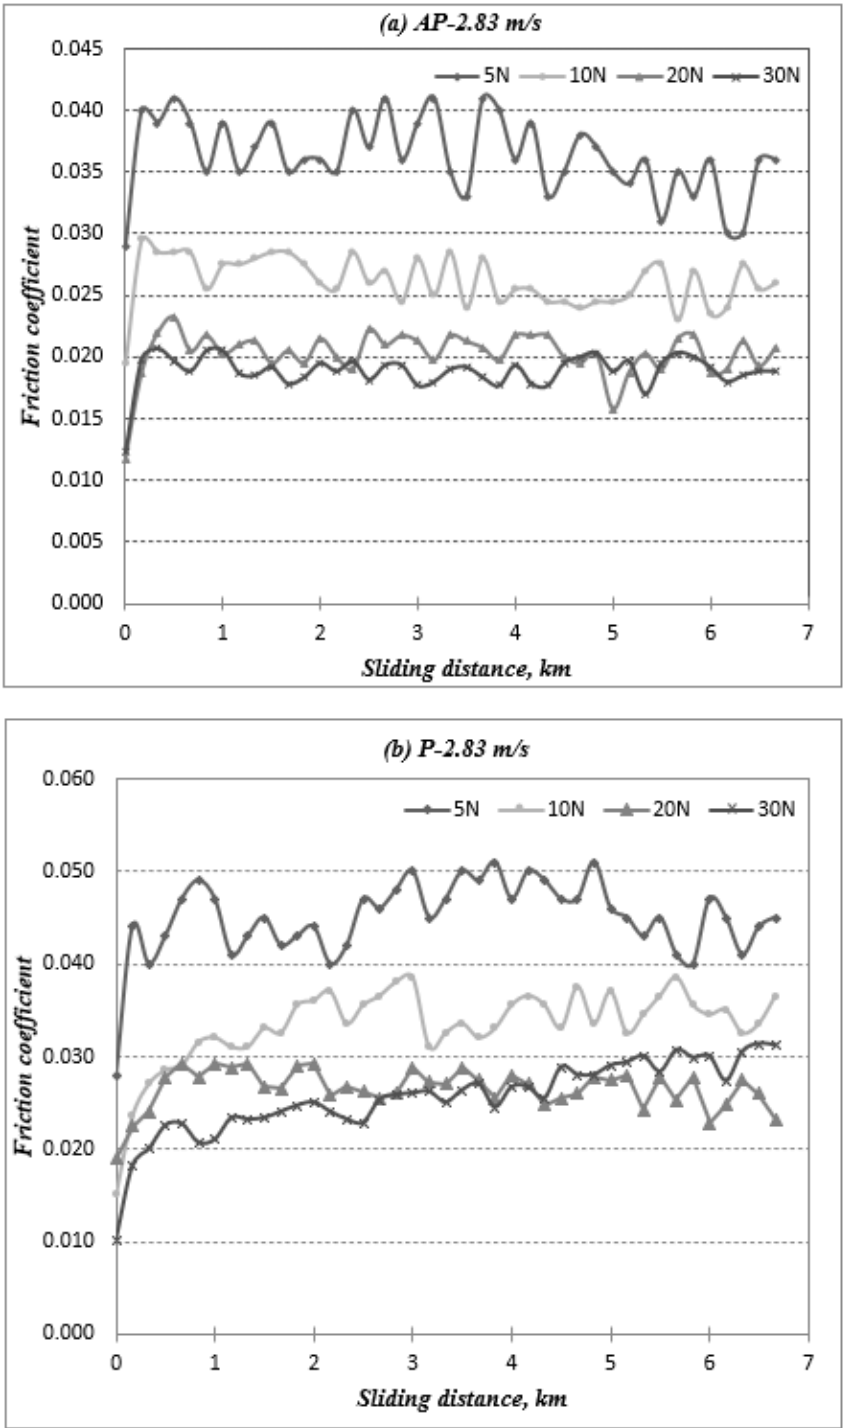
Figure A2. Friction coefficient vs. sliding distance for different fibre orientations (AP and P) subjected to different applied normal loads at 2.83 m/s of sliding velocity.